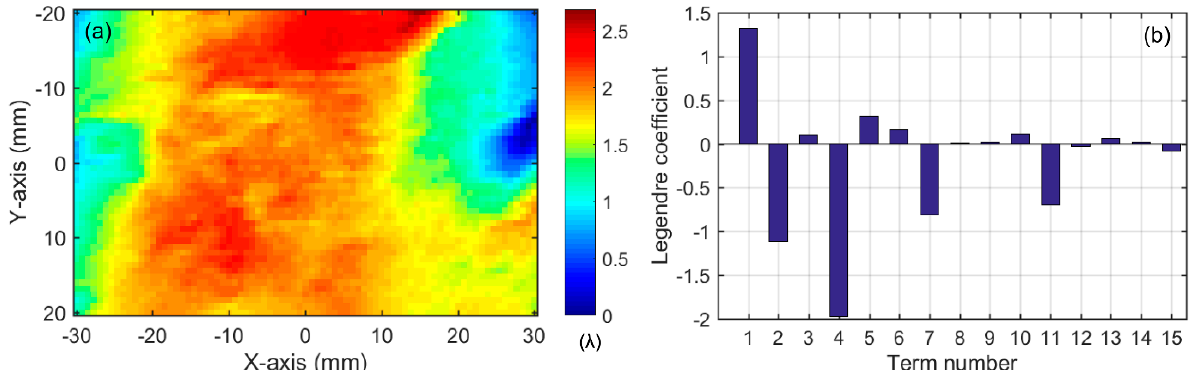
Figure 13. Single-pass thermally induced wavefront aberration through the amplifier. ( a ) measured wavefront aberration; ( b ) analysis of wavefront aberration by Legendre polynomials.